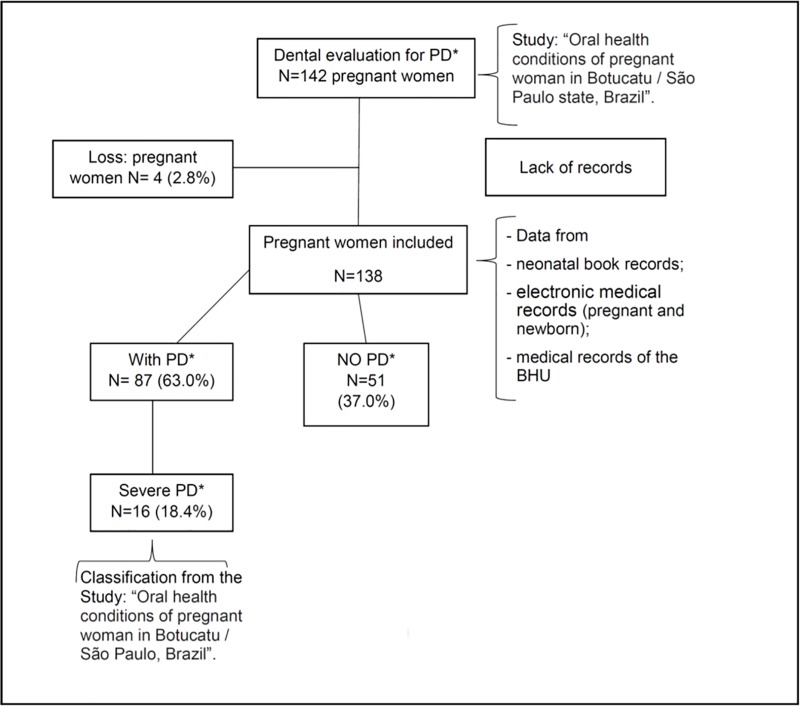
Flowchart of data collection and inclusion of pregnant women.* PD = periodontal disease.